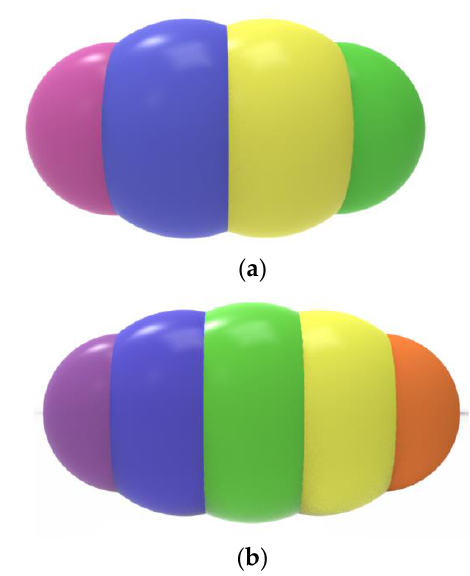
* 4 M * 5 M spheres; ( b ) by spheres. ,